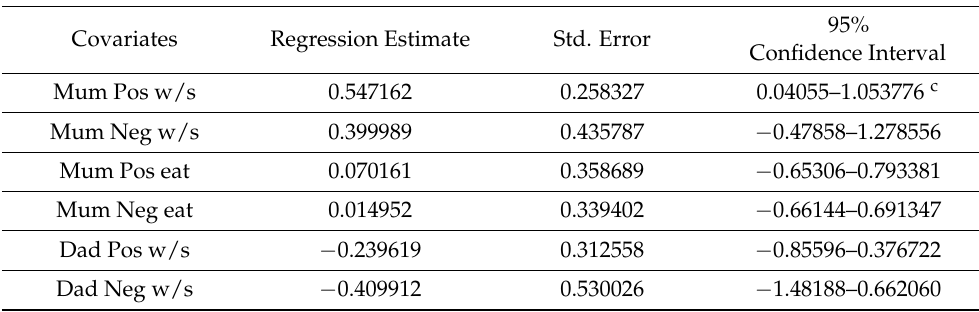
Table 2. Multiple linear regression results for the effects of maternal and paternal comment variables on psychological distress, BMI, eating disorder cognitions, and paediatric quality of life at one-year follow-ups for